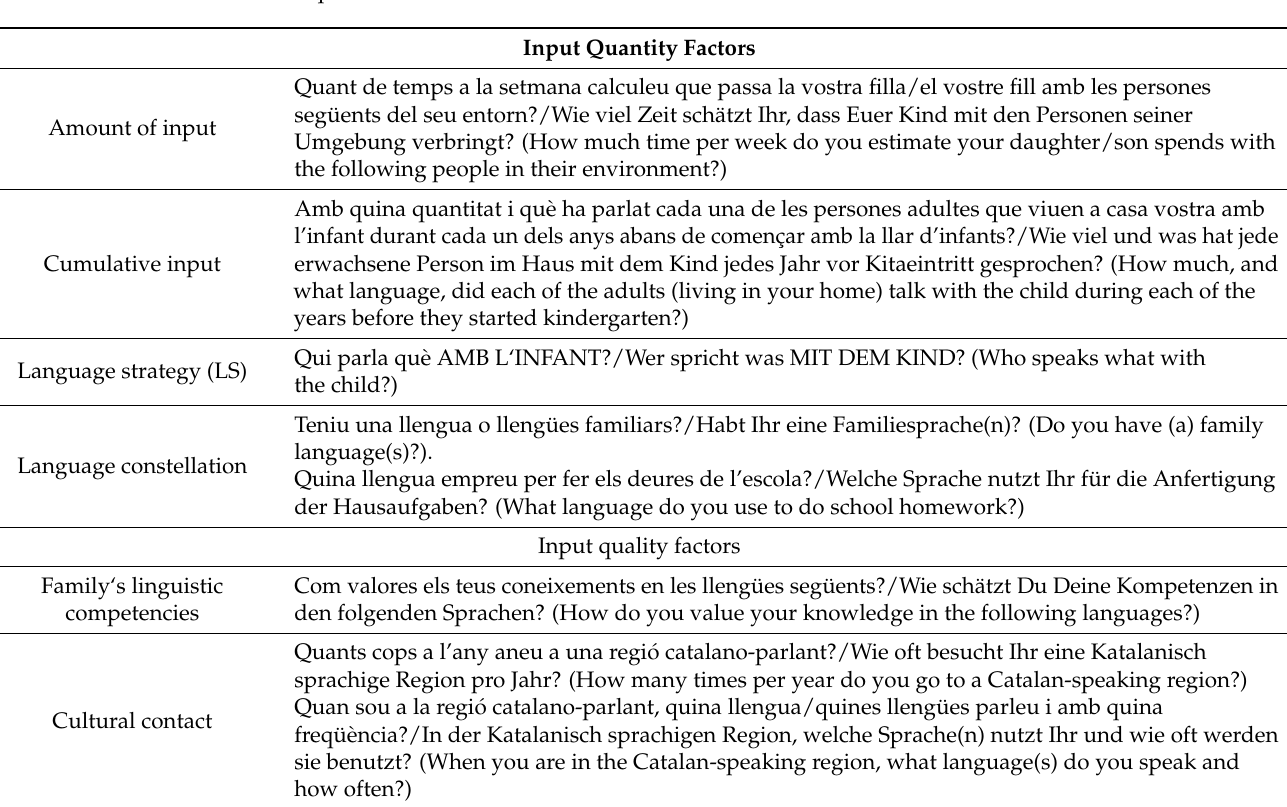
Table A1. Instances of questions on input quantity and quality factors being treated in the parental